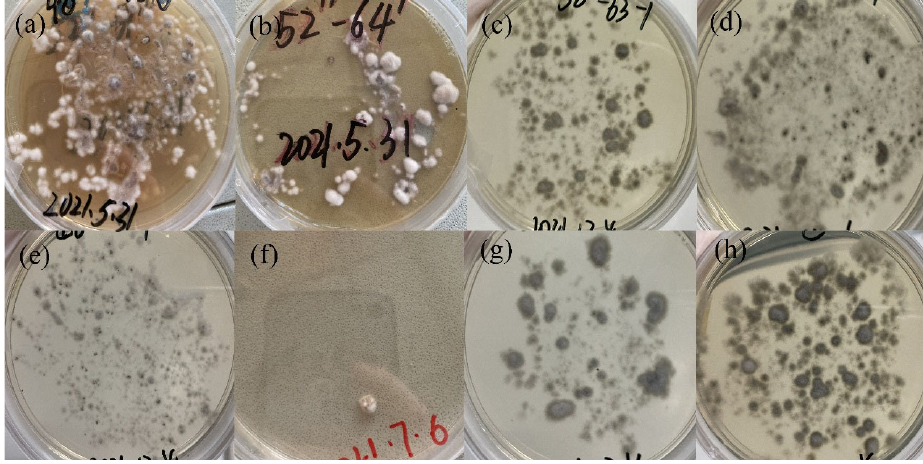
Figure 6. The colonial morphology of strain in PDA medium. ( a ) was mutant 55, ( b ) was mutant 64, ( c ) was mutant 63, ( d ) was mutant 70, ( e ) was mutant 2, ( f ) was mutant 61, ( g , h ) were original strains.).